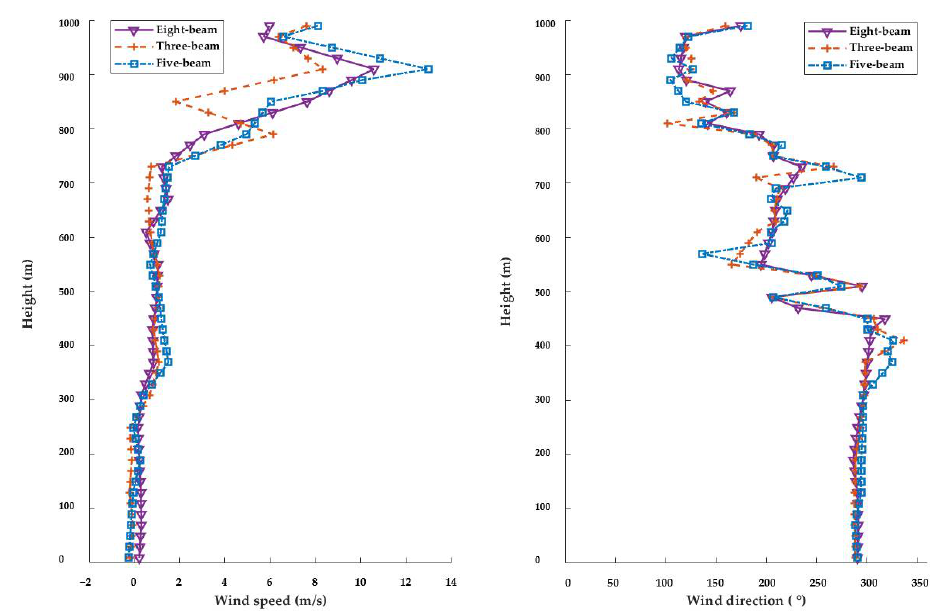
Figure 9. Comparisons of the calculation results of the eight-beam check with the three-beam and five-beam wind measurements.